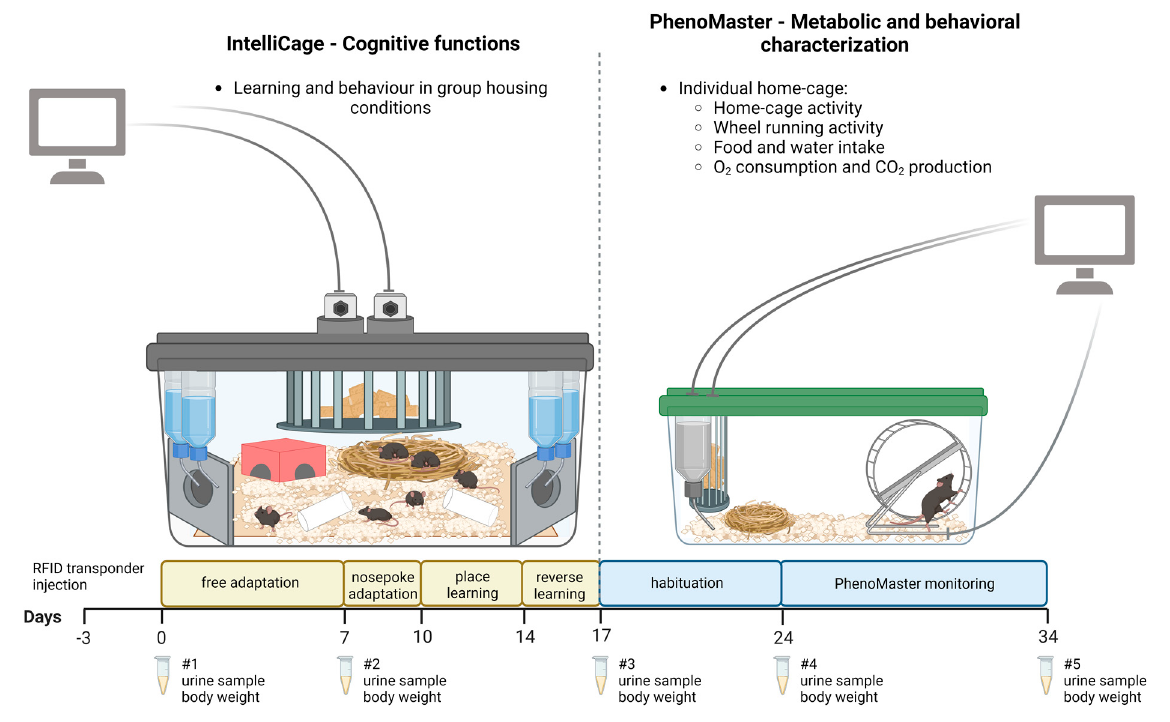
Figure 5. Simplified schematic representation of the study design including the IntelliCage and PhenoMaster measurements. RFID (radiofrequency identification) transponders were injected sub- cutaneously into 9.5-week-old mice at the beginning of the study. Urine samples and weights were collected at five time points throughout the experimental setup (#1–#5). Created with Biorender.com.